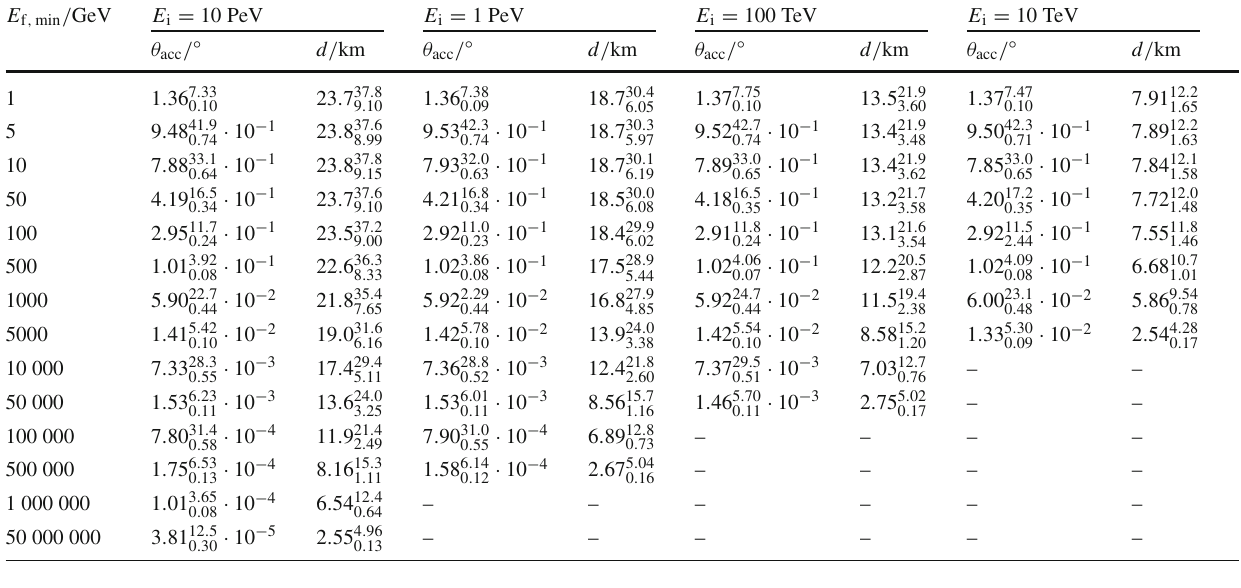
and ice. Since the result can be interpreted as the deflection before the detector entry, it defines a lower limit on the direc- tional resolution. At energies lower 1 TeV, there is potentially a small impact of the muon deflection on the angular resolu- tion of